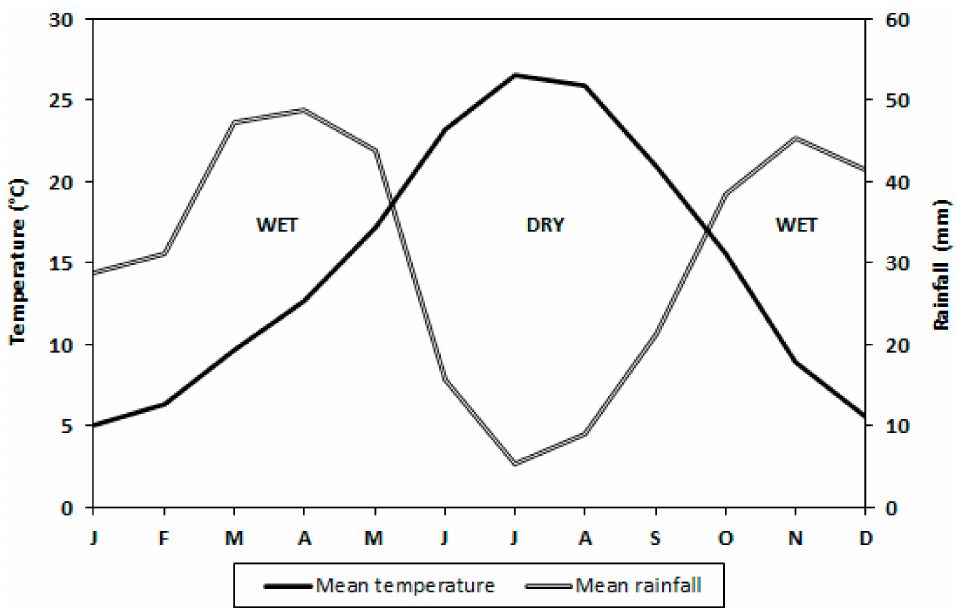
Figure 1. Climogram of the area based on climate historical data from 2001 to 2020.